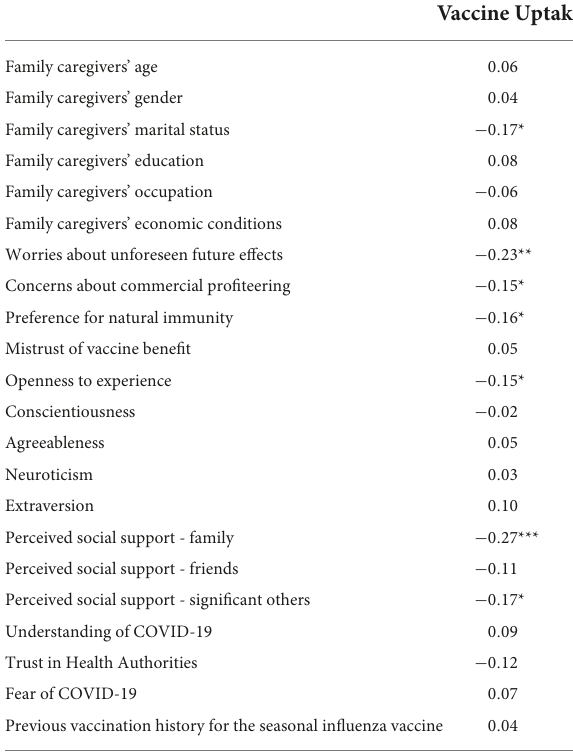
TABLE 3 Response rates of family caregivers to questions related to COVID-19.